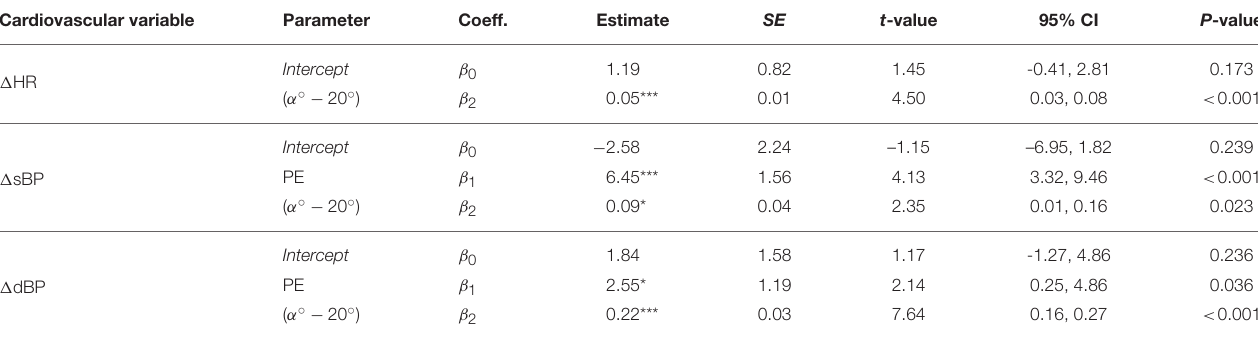
TABLE 3 | Statistical models for 1 HR, 1 sBP, and 1 dBP in secondary analysis, i.e., when PE and head-up tilting effects are considered together. Cardiovascular